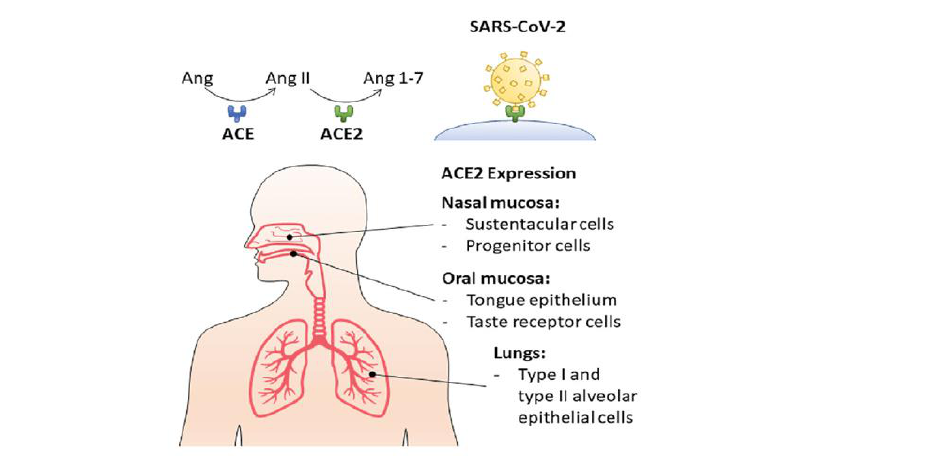
Figure 1. The human oral cavity and nasopharynx to which particles of SARS-CoV-2 attach https://www.researchgate.net/publication/342577883, accessed on 3 June 2021.